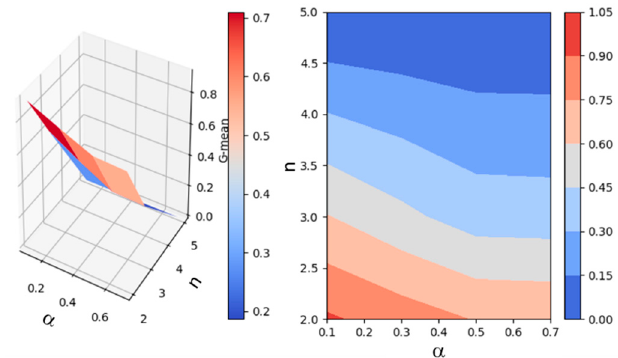
Figure 8. Selection of SEP algorithm parameters for smartwatch data based on a performance analysis for a sample of the first ( n = 10,000) data points.